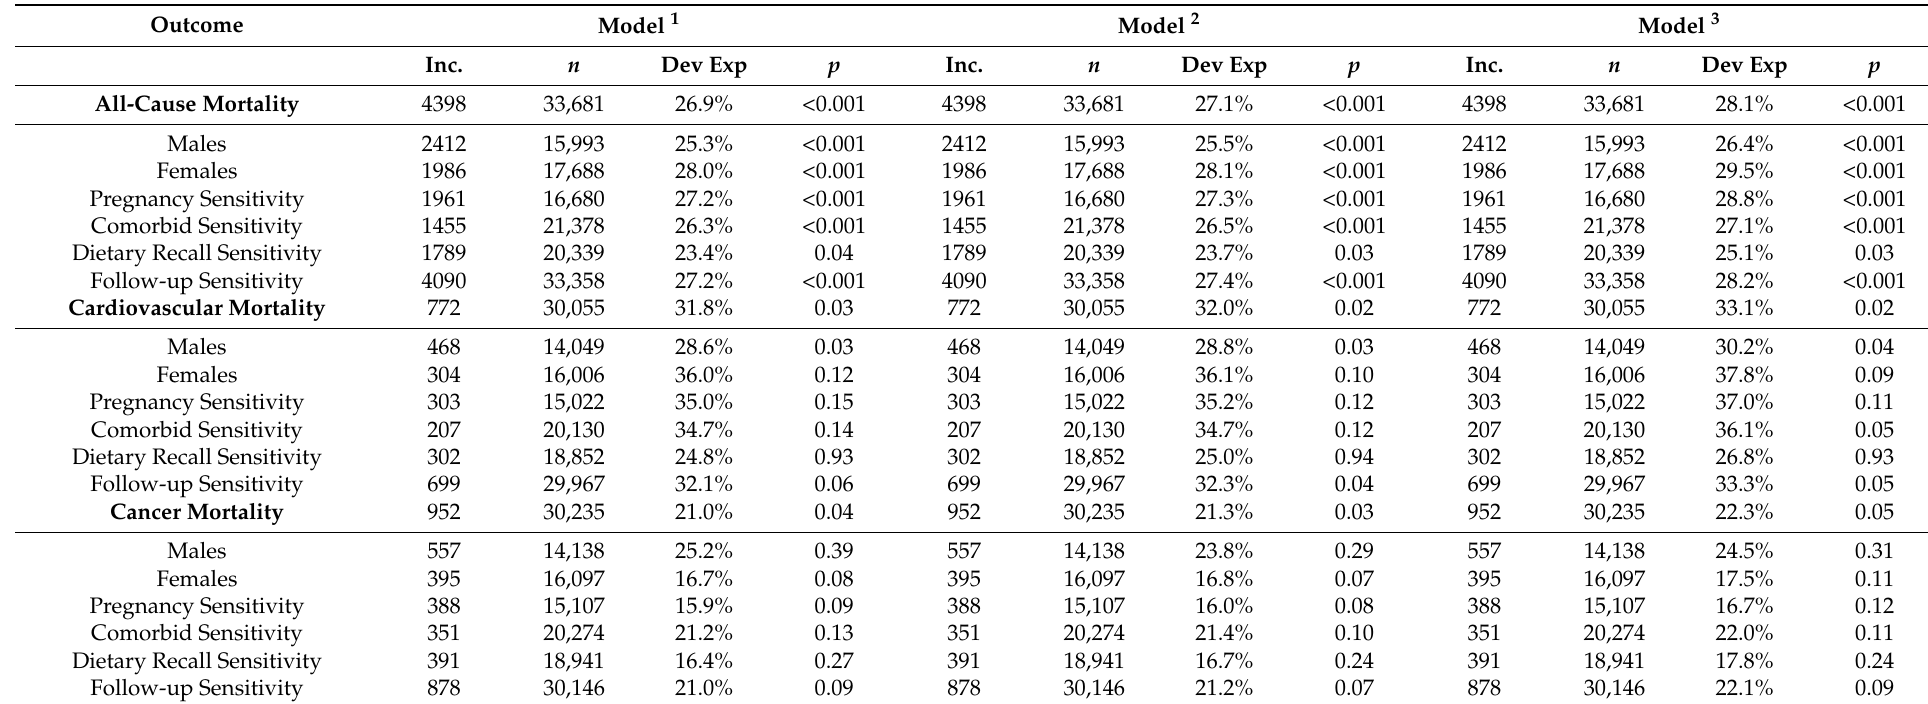
Table 2. Generalized additive models for macronutrient intake and mortality